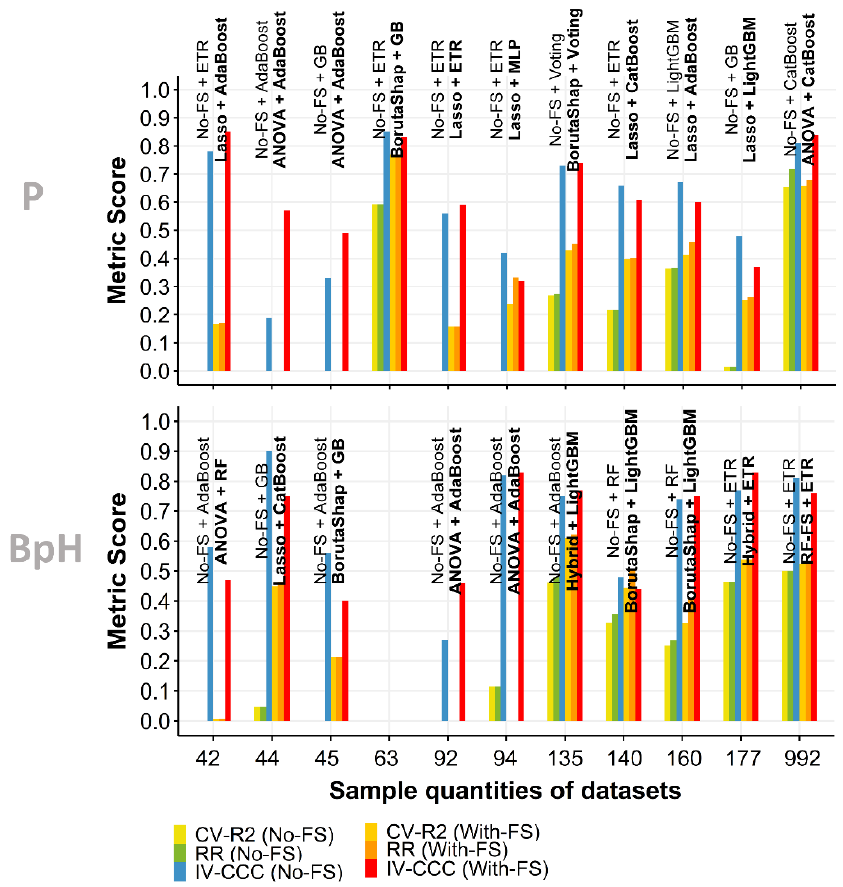
Figure 8. Same comparisons as Figure 7 are shown here for P and BpH. Optimal combinations of FS and ML outperformed No-FS for six (P) and five (BpH) sample sets, out of the eleven sample sets tested. These results for improvement of model performance with FS were lower compared to SOM, K, and NO 3 − .